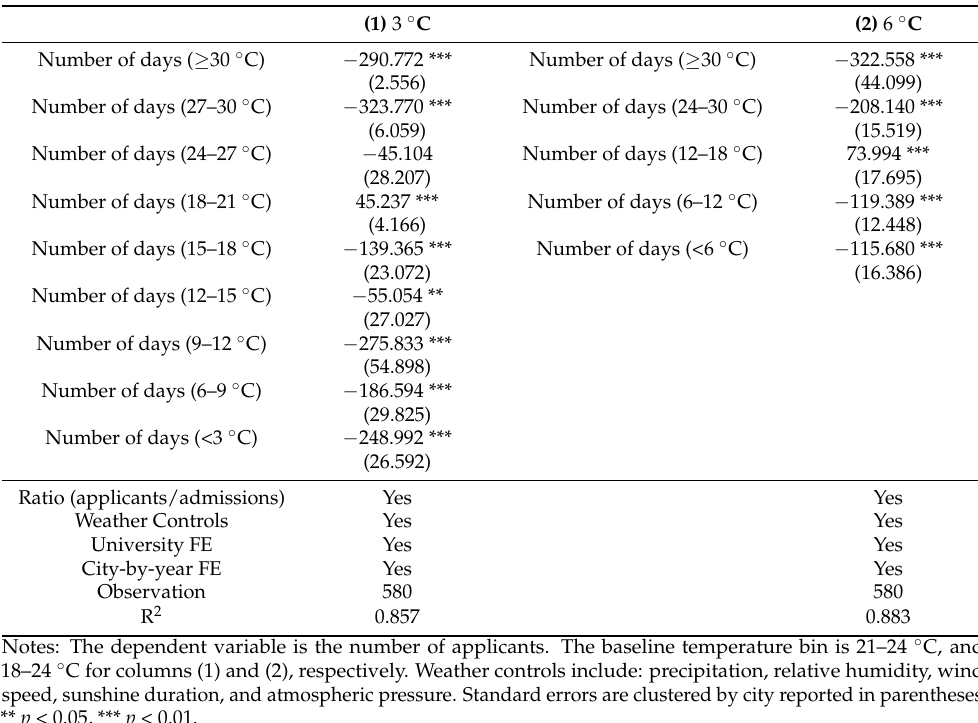
Table 7. Robustness checks: alternative temperature bins.